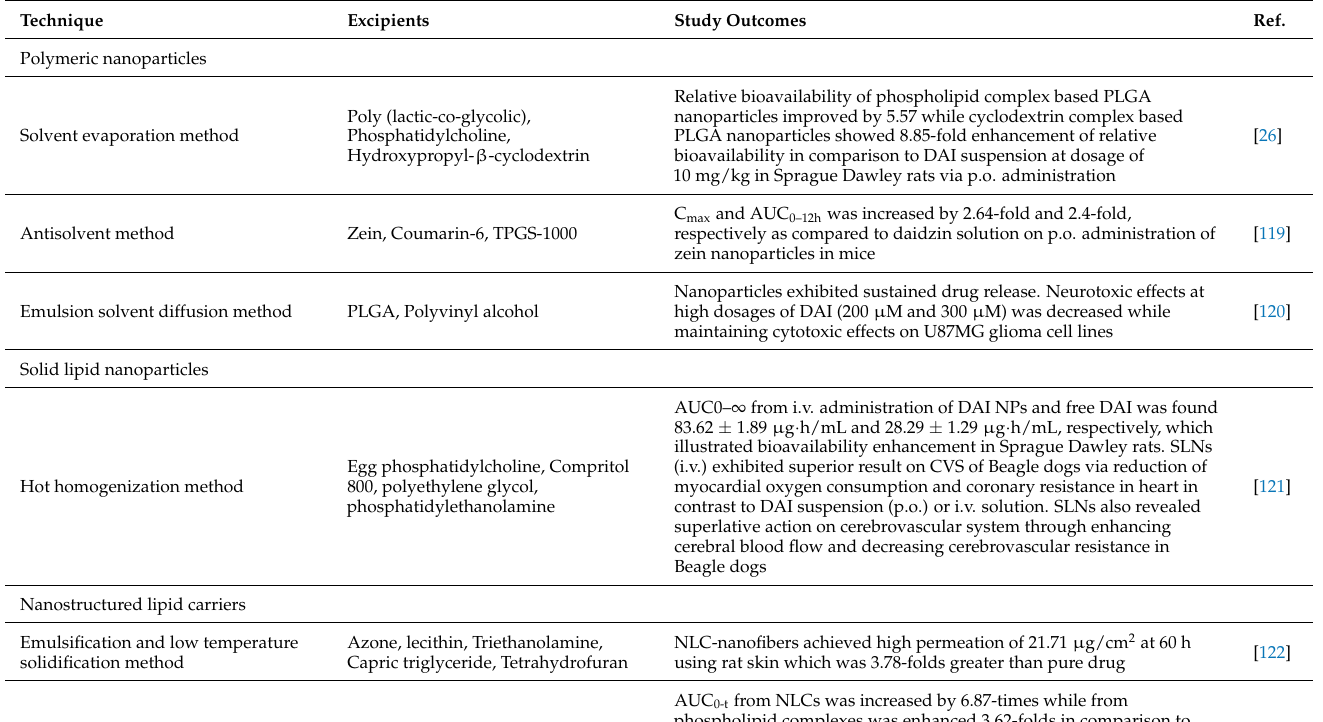
Table 3. Review of up-to-date progression in development of nanocarriers based drug delivery of DAI for solubility and bioavailability